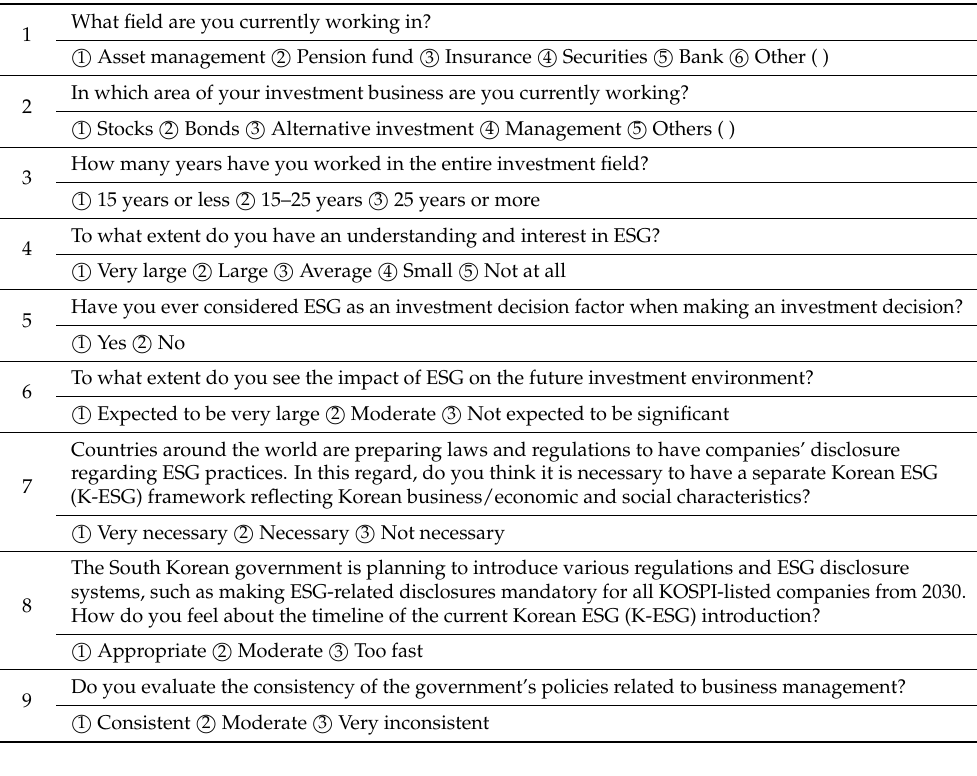
Table A1. Basic data for survey respondents.